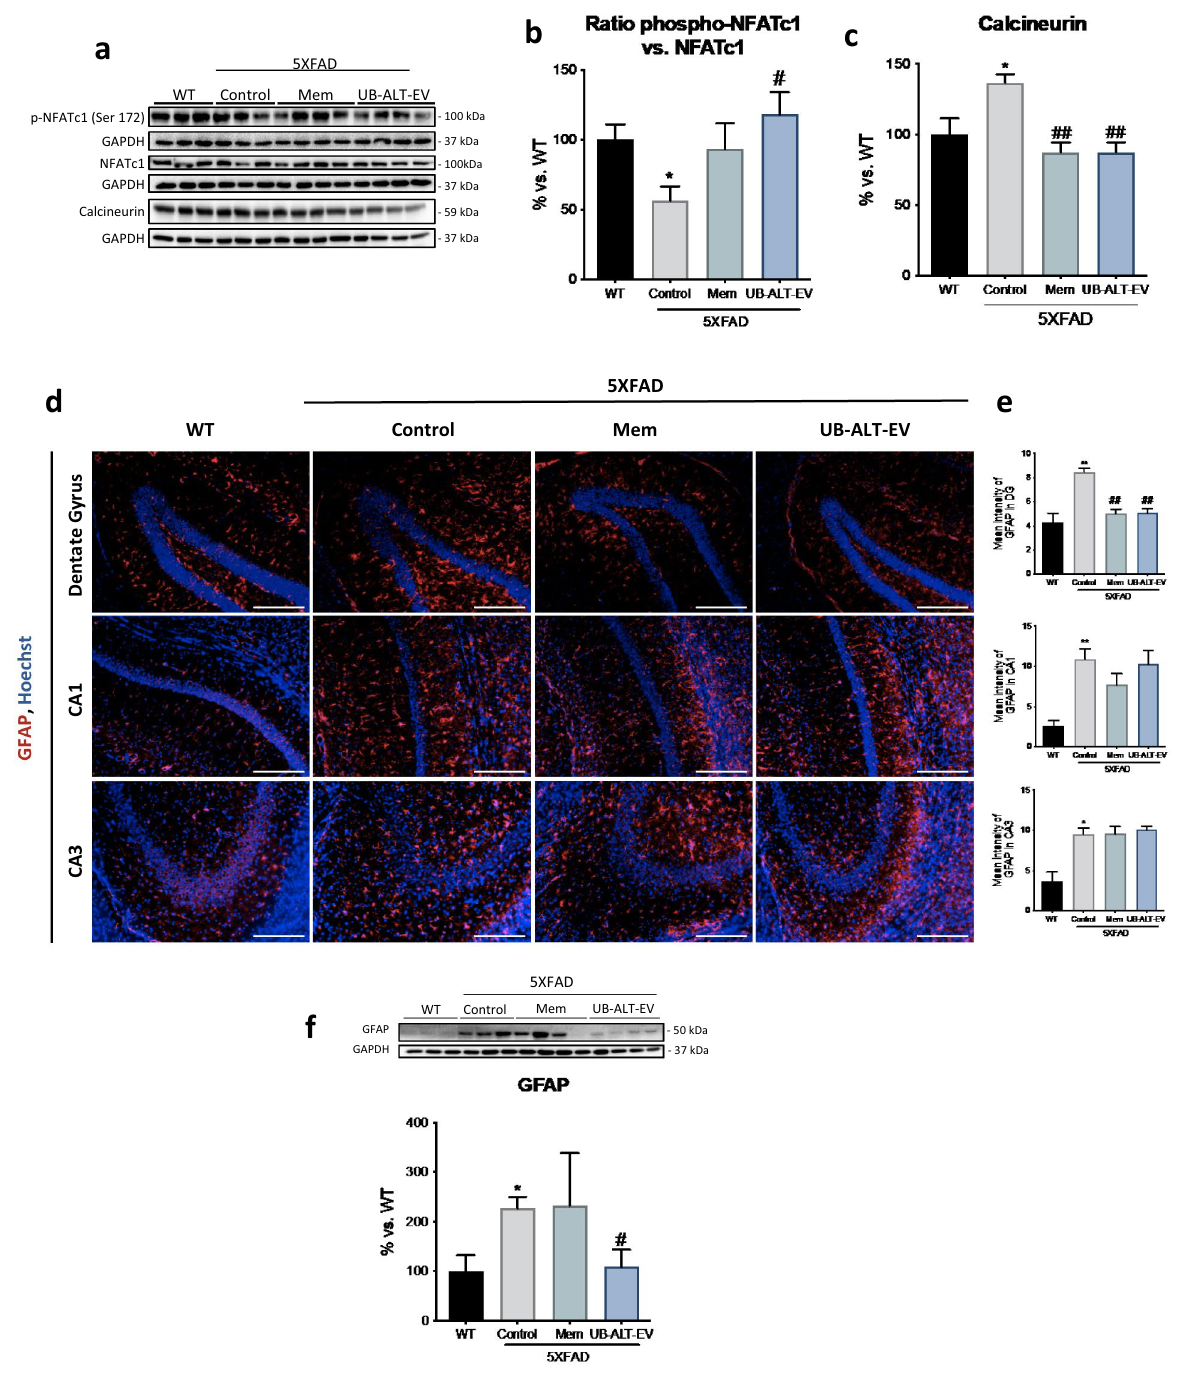
Figure 1. Treatment with UB-ALT-EV changed the protein expression of inflammatory and astrocytic activation markers and in 5XFAD mice. Representative Western Blot ( a ) and quantifications for ratio phospho- NFATc1 vs. NFATc1 ( b ) and CaN ( c ). Values in bar graphs are adjusted to 100% for protein levels of the wild type (WT). Representative GFAP (Red) and Hoechst (Blue) positive staining in dentate gyrus, CA1 and CA3 hippocampal areas ( d ). Scale bars: 200 μm. Mean intensity of GFAP staining in dentate gyrus, CA1 region, and CA3 region ( e ). Representative Western Blot and quantification for GFAP ( f ). Values are the mean ± Standard error of the mean (SEM); (n = 3 for WT and Control groups and n = 4 for Mem and UB-ALT-EV groups. For WT vs. 5XFAD Control groups data was analyzed using a two-tail Student’s t-test, and for 5XFAD groups a standard one-way ANOVA followed by Tukey post-hoc analysis was performed. *p < 0.05; **p < 0.01 for WT vs. Control. # p < 0.05; ## p < 0.01 for Mem or UB-ALT-EV vs.